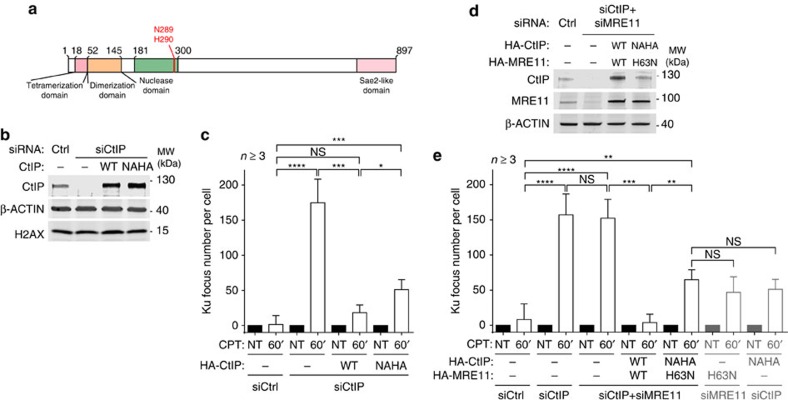
CtIP 5′-flap endonuclease activity shows epistasis with MRE11 3′–5′ exonuclease activity in counteracting Ku binding to seDSBs.(a) Schematic of CtIP domains with the position of N289 and H290 residues. (b) Immunoblotting of extracts from U2OS T-REx cells stably transfected with control or siRNA-resistant wild-type (WT) or NAHA HA-CtIP-expressing plasmids, and transfected with the indicated siRNA. (c) Quantification of Ku focus number in replicating cells transfected as in b and treated with CPT. (d) Immunoblotting of extracts from U2OS T-REx cells stably transfected with control or siRNA-resistant WT HA-CtIP and HA-MRE11 or NAHA HA-CtIP and H63N HA-MRE11, and transfected with the indicated siRNAs. (e) Quantification of Ku foci in U2OS T-REx stably transfected with control or the specified siRNA-resistant constructs and transfected with the indicated siRNAs. Error bars are s.d. Significant differences between specified pairs of conditions, as judged by t-test, are highlighted by stars (*P<0.05; **P<0.01; ***P<0.0005; ****P<0.0001). NS, non-significant difference.